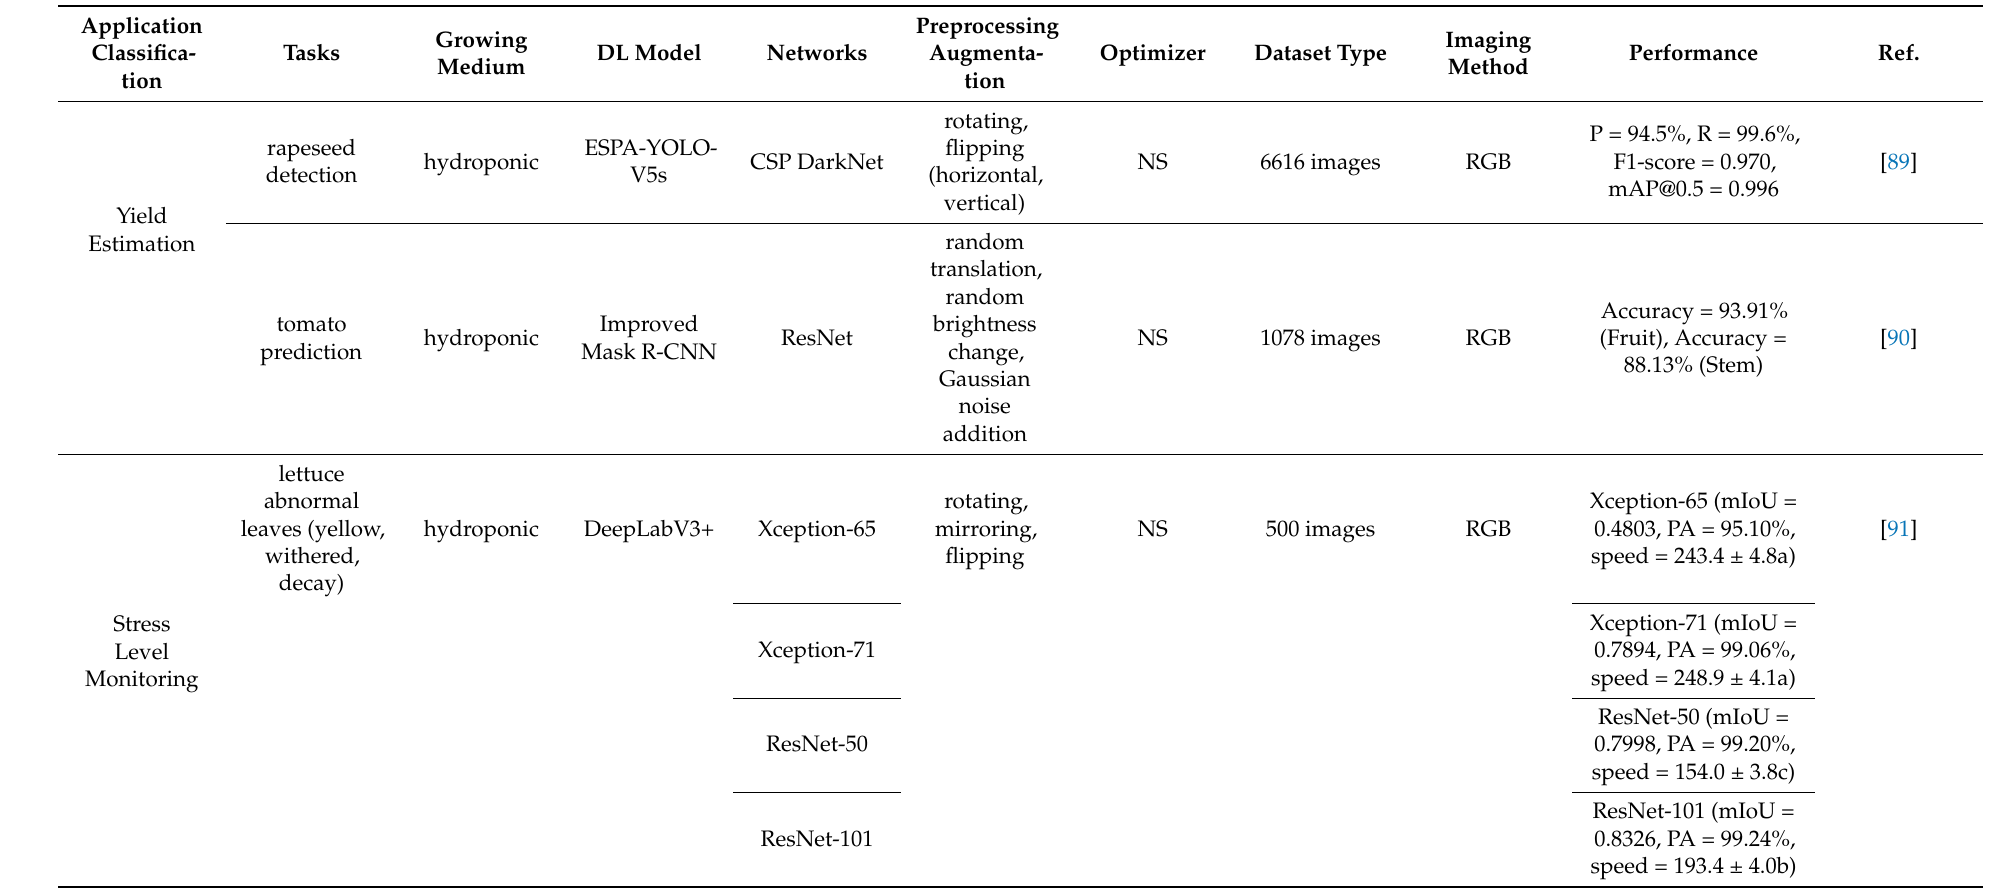
Table 4. Summary of studies for deep learning applications in indoor